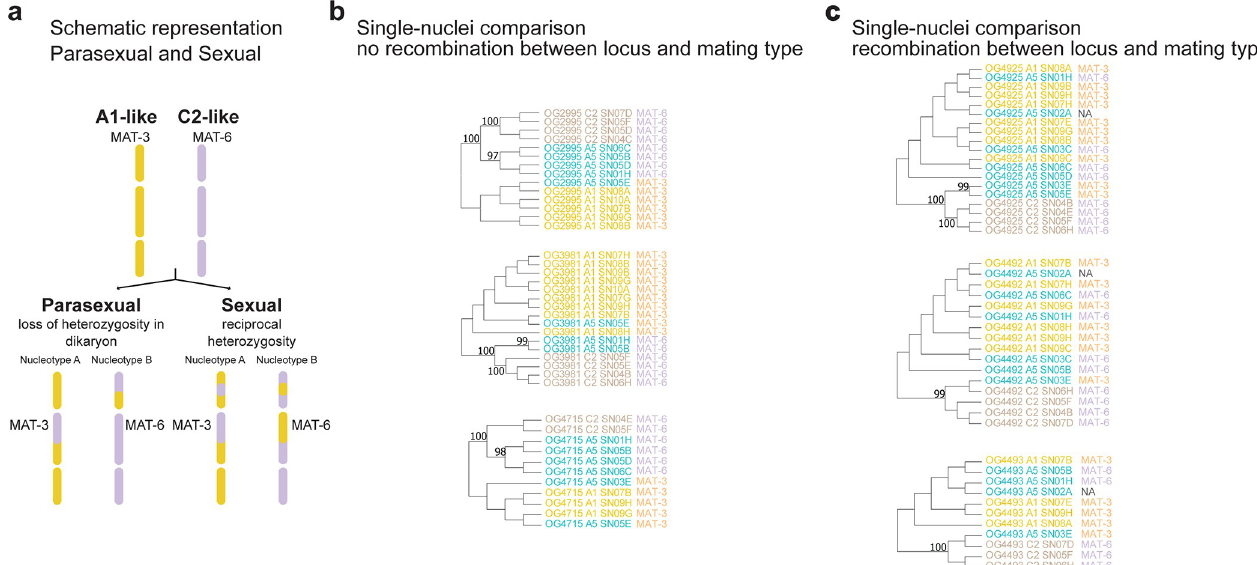
Fig 5. Recombination events in nucleotype-specific genes in A5 isolate. a, Schematic representation of possible outcomes after fusion of two different isolates. Please note the schema illustrates different contigs, separated by blank lines and no different chromosomes. b, Phylogenetic relationship of different nucleotype-specific alleles among different nuclei from A1, A5 and C2 isolates. Cases where no recombination was detected. Nuclei having the same MAT-type clustered together. c , Phylogenetic relationship of different nucleotype-specific alleles among different nuclei from A1, A5 and C2 isolates. Cases where recombination was detected. Nuclei having the same MAT-type did not clustered together. We performed 100 bootstraps for the branch support of all phylogenetic constructions.